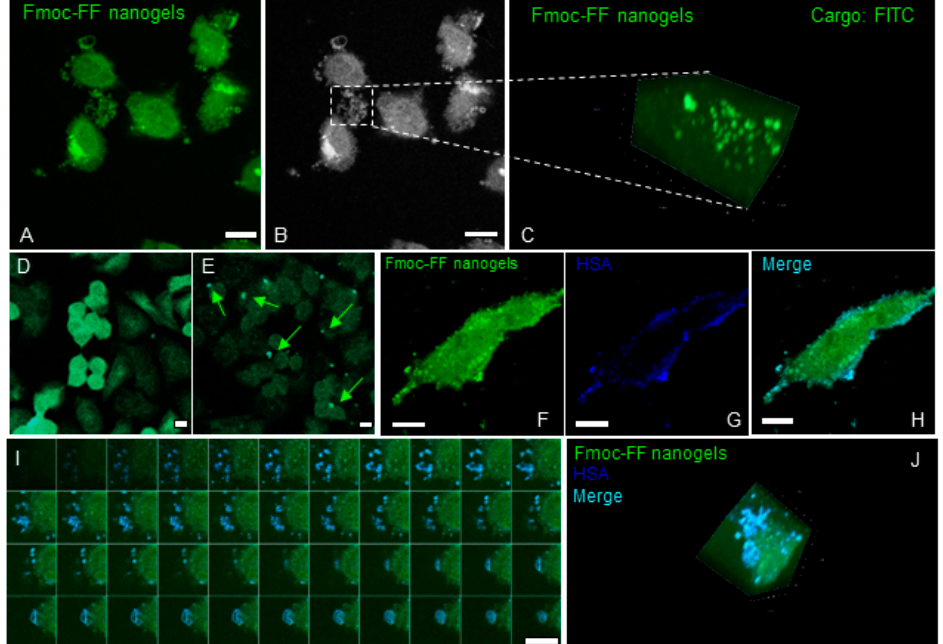
Figure 5. Fmoc-FF nanogels are internalized in MDA-MB-231 cells via HSA containing vesicle. ( A ) Confocal images showing the intracellular localization of FITC-loaded Fmoc-FF nanogels (green signal) upon their incubation with MDA-MB-231 cells for 1 h at 37 ◦ C. ( B , C ) 3D rendering of a Z-stack gallery of confocal sections showing FITC-loaded Fmoc-FF nanogels in intracellular vesicles ~100 nm in diameter. ( D , E ) Confocal images showing the fluorescence of FITC-loaded Fmoc-FF nanogels incubated with MDA-MB-231 cell for 1 h at 4 ◦ C (( D ), note the PM staining of the FITC signal) and then switched to 37 ◦ C for 10 min (( E ), note the vesicular staining of the FITC signal). ( F – H ) Colocalization of Fmoc-FF nanogels (green, ( F )) and HSA containing vesicles (blue, ( G )) in MDA-MB-231 cells; the merge in panel H shows, in cyan, a region of colocalization between green and blue signals. ( I , J ) Gallery ( I ) and 3D rendering ( J ) of confocal z-sections showing FITC-loaded Fmoc-FF nanogels (green) colocalizing with has (blue) containing vesicles. Cyan indicates a region of colocalization between nanogels and HSA. (For all panels, magnification bar = 14 µ m). Their dimension should not be compatible with clathrin-dependent endocytosis